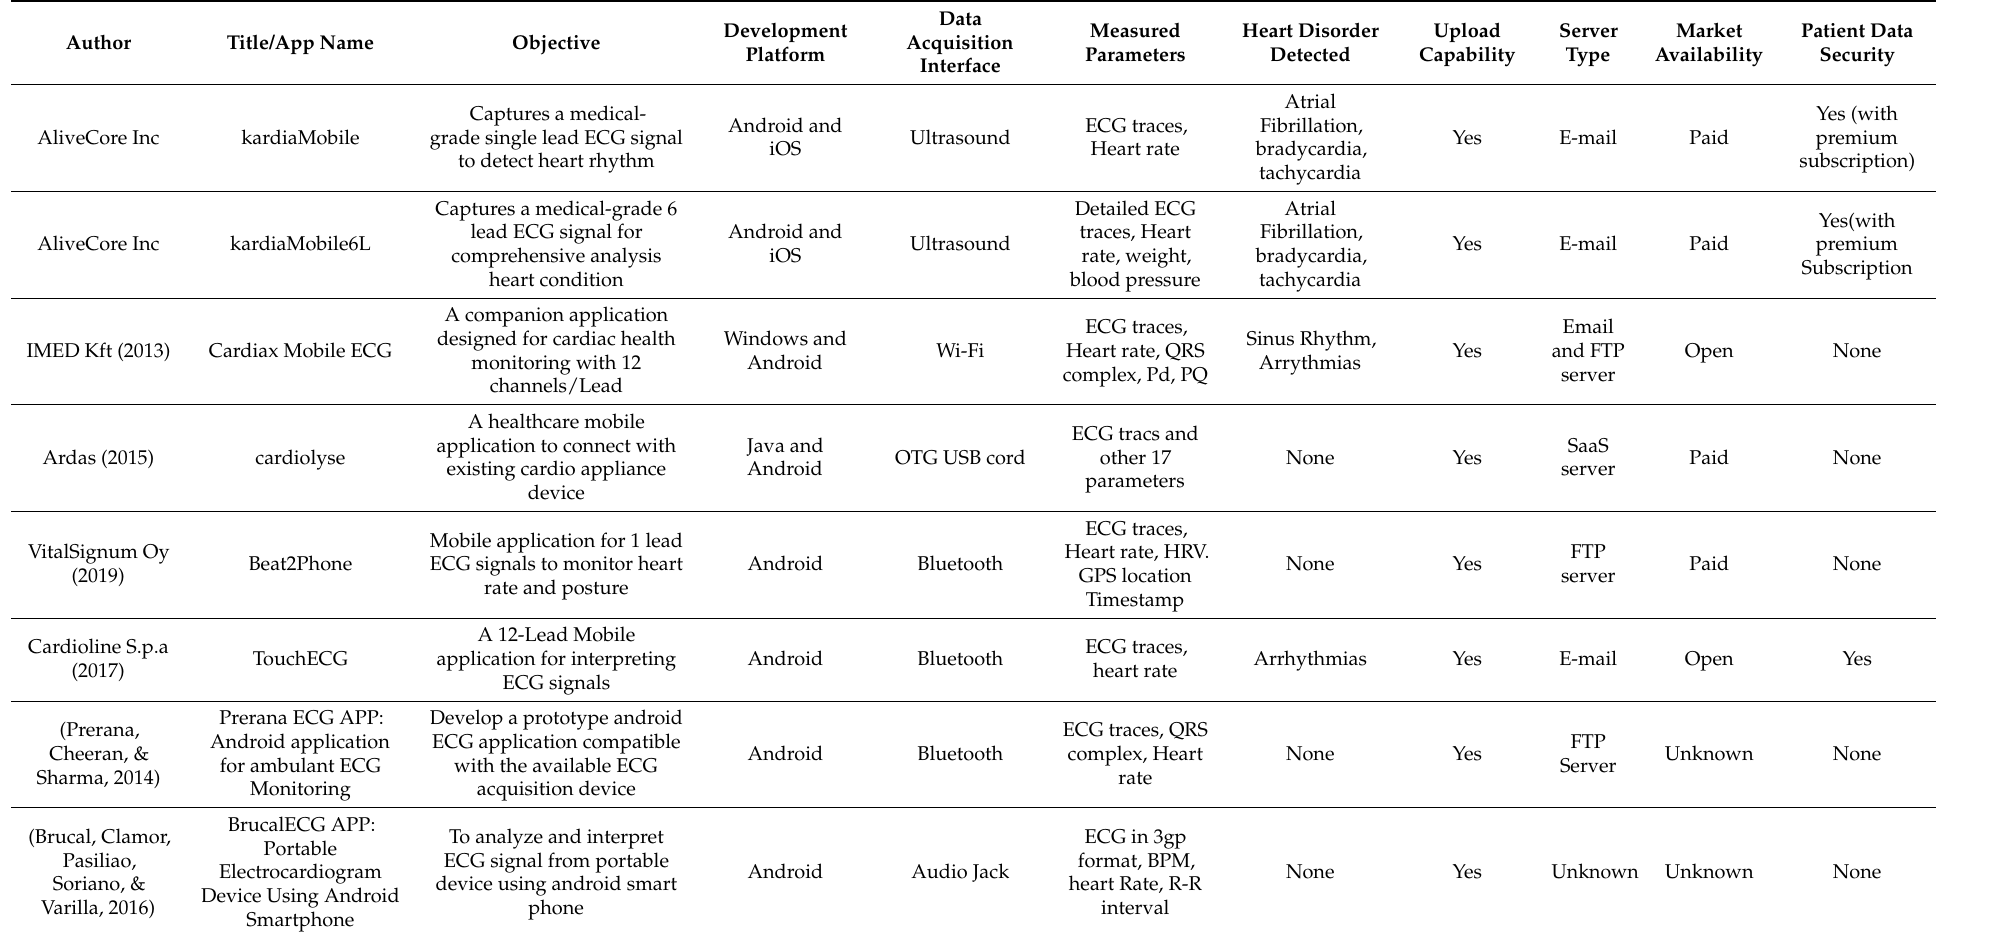
Table 2. The appraisal of mobile applications for ECG